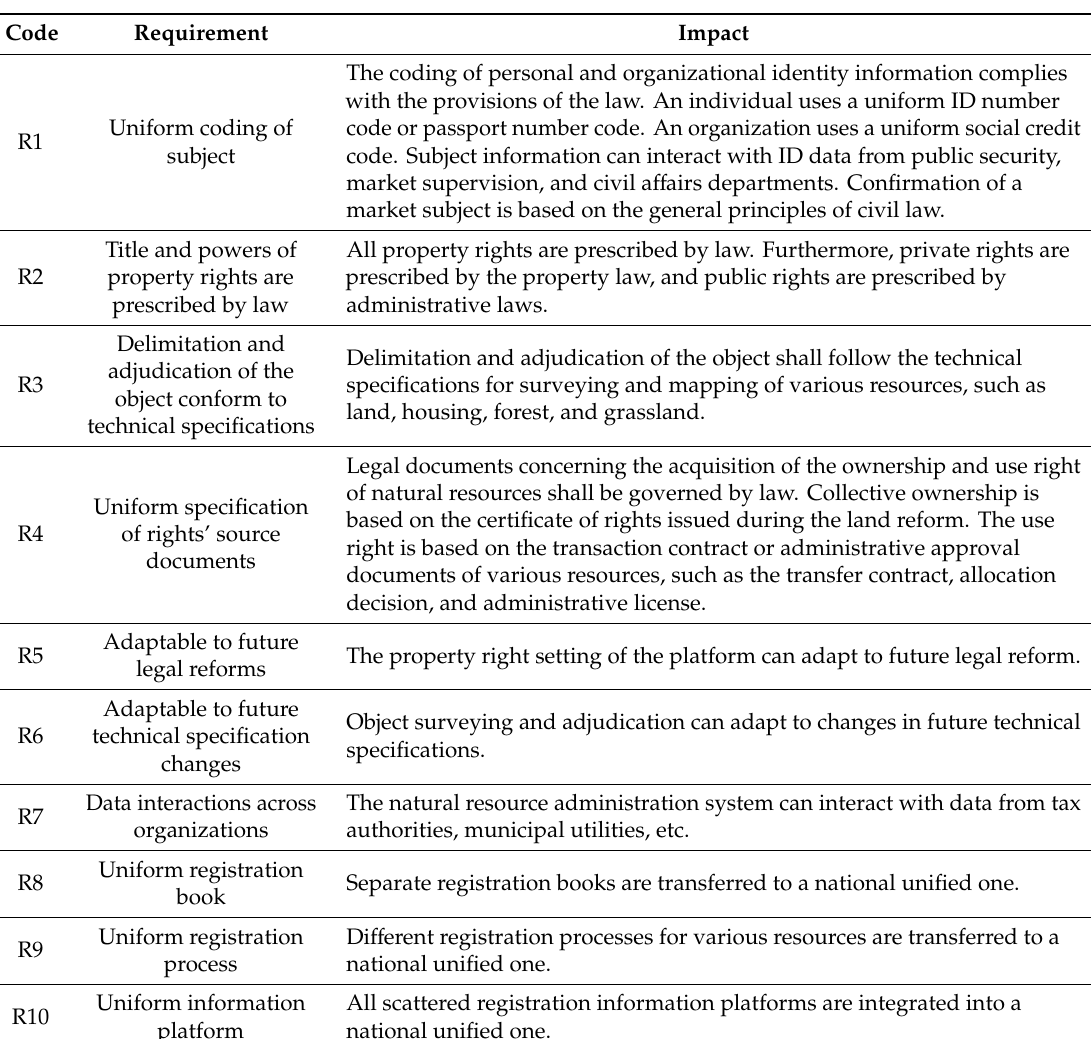
Table 1. User requirements for the information platform of natural resource